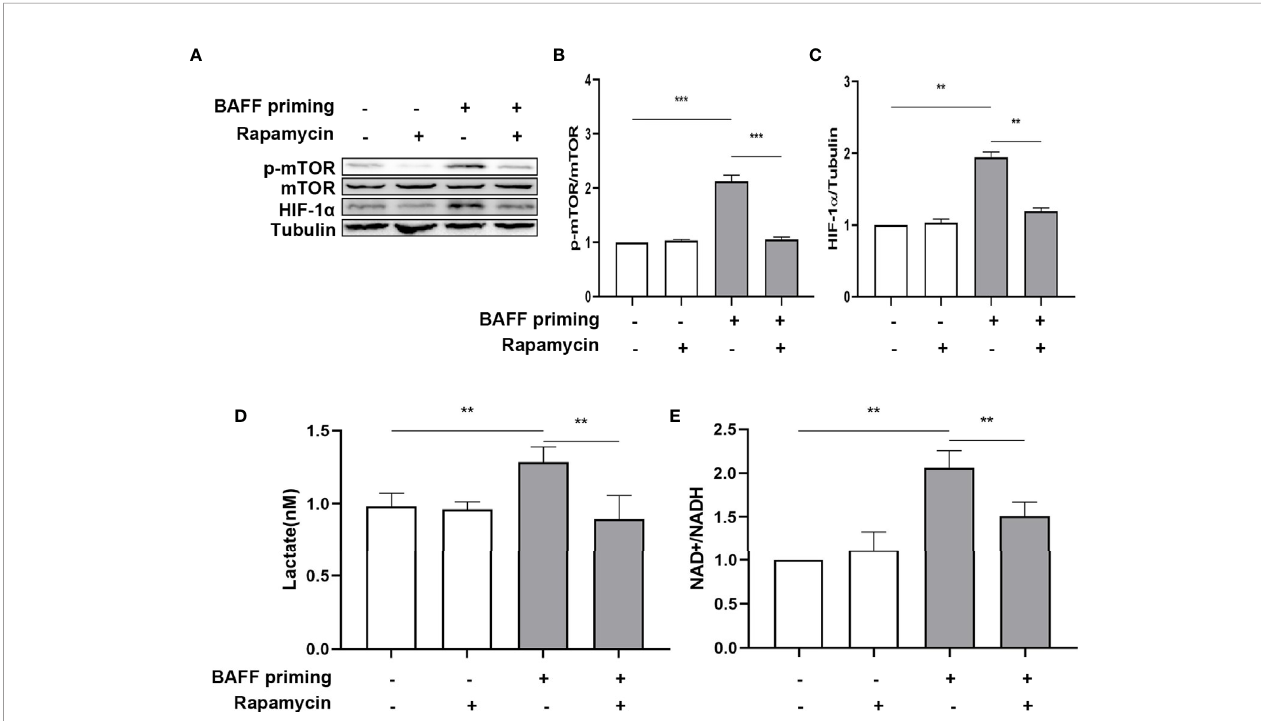
FIGURE 6 | BAFF-induced metabolic reprogramming was blocked by rapamycin in BV2 cells. (A) On day 0, BV2 cells were pretreated with 100 nM rapamycin for 1 h and then treated with vehicle or BAFF (10 ng/ml) for 24 h, rested for 5 days. BV2 cells were lysed on day 6. Whole-cell extracts were subjected to western blot for the expression level of mTOR, p-mTOR, and HIF-1 a . Densitometric quanti fi cation of p-mTOR/mTOR (B) and HIF-1 a /tubulin (C) in (A) (n = 9). (D) Lactate was measured in the culture supernatants on day 6 (n = 12). (E) The ratio of NAD+/NADH was detected in whole-cell lysates on day 6 (n = 9). Data are mean ± SEM; Kruskal-Wallis test with Turkey post hoc test; **p < 0.01, and ***p <